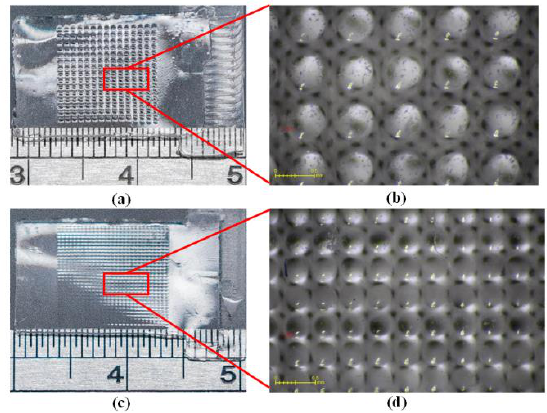
Figure 7. ( a ) Final MLA based on Design I; ( b ) final MLA based on Design II; ( c ) enlarged image showing MLA based on Design I; and, ( d ) enlarged image showing MLA based on Design II.